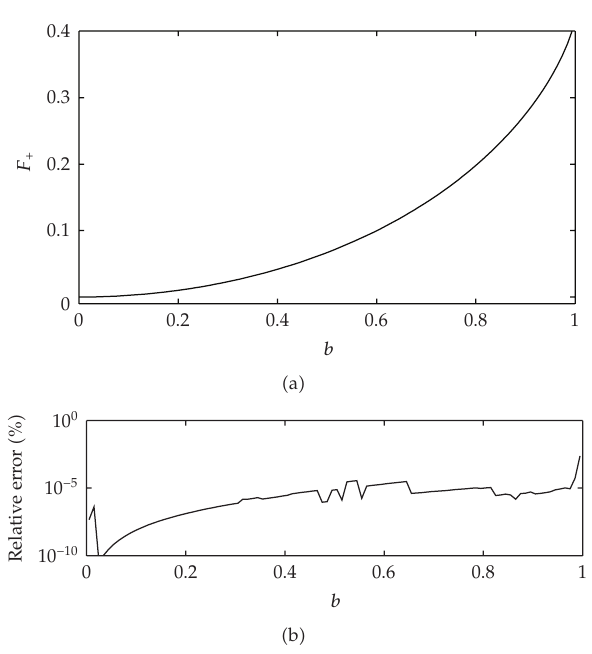
Figure 4: The series F (cid:10) from (cid:2) 3.12a (cid:3) with the relative error when compared to the integral from (cid:2) 3.16a (cid:3)